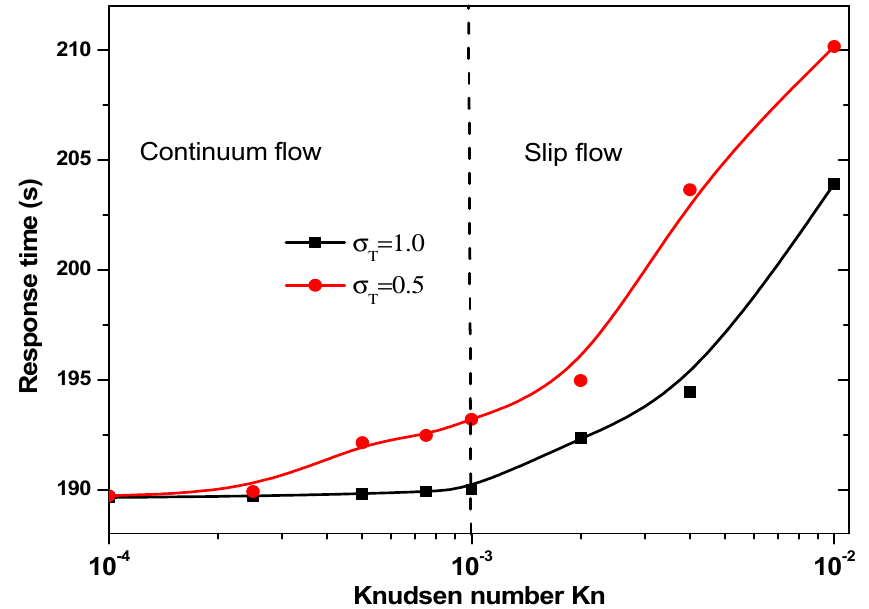
Figure 10. Response time versus the Knudsen number for second structure.